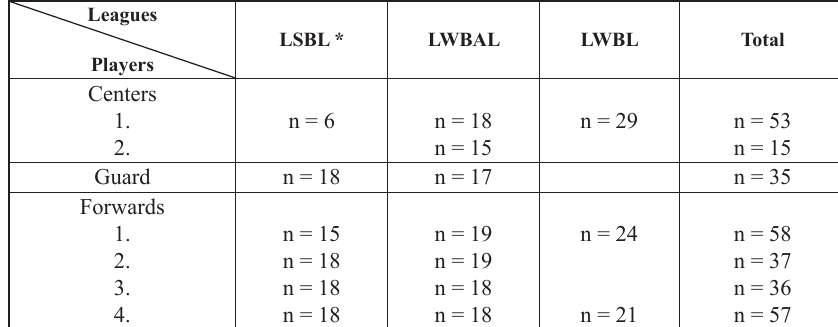
1. The number of Lithuanian basketball players in different basketball leagues